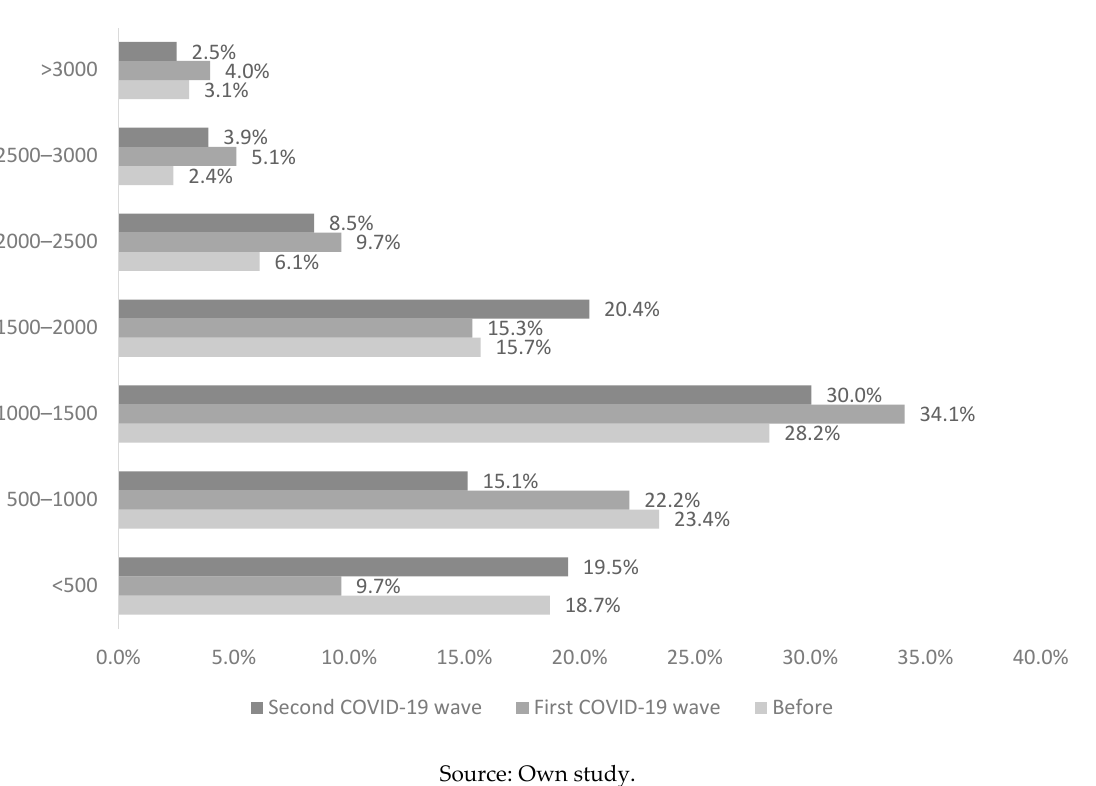
Figure 2. Changes in living costs over the course of the pandemic.